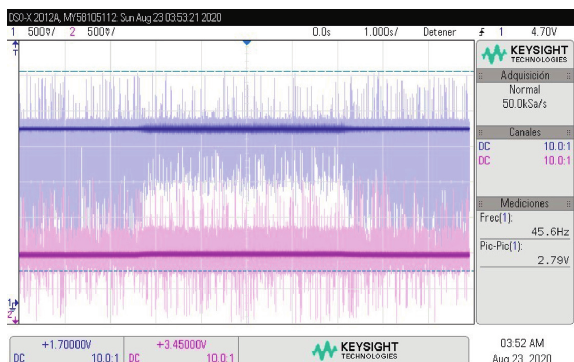
Figure 21: Desired current (magenta) and measured current (blue) for the FOSM